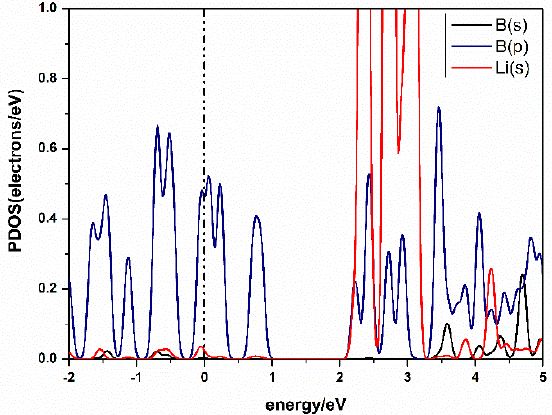
Figure 4. Partial density of states (PDOS) of Li-decorated β 12 -borophene system.